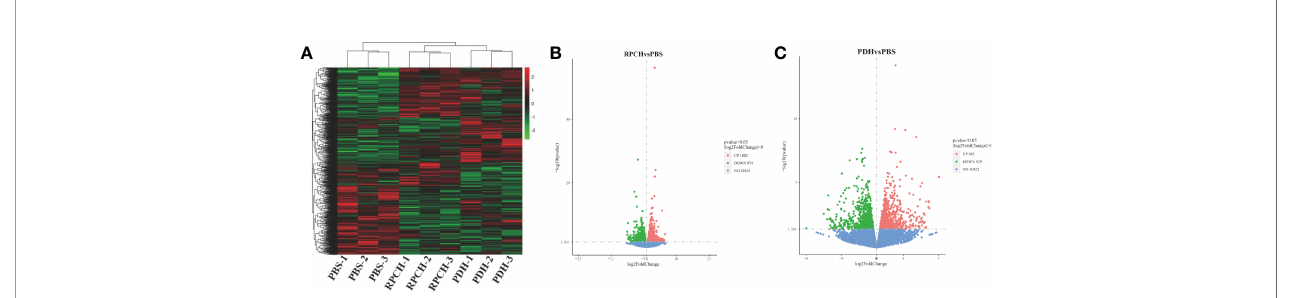
FIGURE 7 | Comparative transcriptome analysis of the ovaries from the individuals ( n = 3) injected with PBS, Es-RPCH and Es- b - PDH peptides. (A) A heat map of differentially expression genes (DEGs) in the ovaries administrated with PBS, Es-RPCH and Es- b - PDH peptides. The color scale indicates that the log10 ‐ fold change from high (red) to low (green). (B) A volcano plot of DEGs between the Es-RPCH administrated and PBS control groups. (C) A volcano plot of DEGs between the Es- b - PDH administrate and PBS control groups. The upregulated, downregulated and non-regulated genes were indicated by red, green and blue dots,